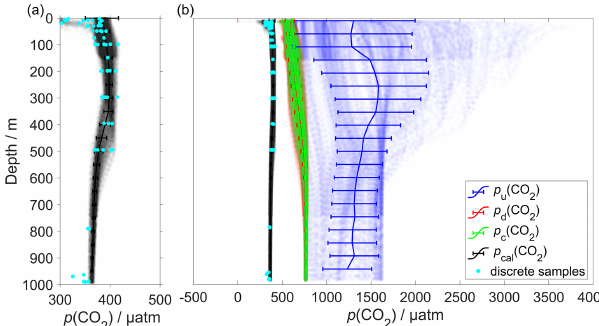
Figure 5. The histogram shows the distribution of the τ calculated from glider dives 31 to 400 to correct the CO 2 optode drift using the algorithm of Miloshevich